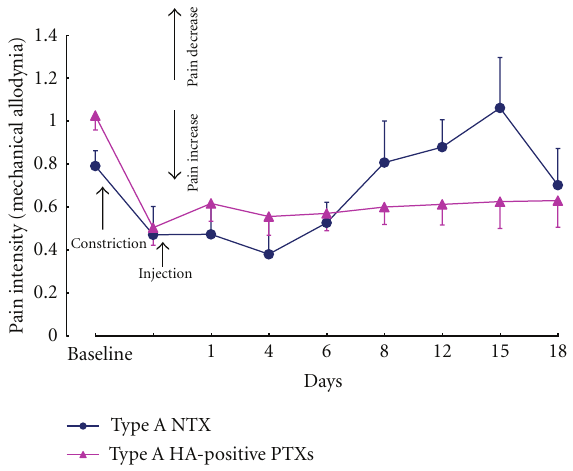
Figure 3: Mechanical allodynia after injection with type A NTX or PTXs in a rat hindpaw neuropathy model. Mechanical allodynia was tested with an electric von Frey filament and the hindpaw withdrawal thresholds measured. The data were divided by the contralateral na ¨ ıve hindpaw data. After sciatic nerve contraction, the ipsilateral hindpaw threshold was decreased. Ipsilateral injection with NTX or HA-positive PTXs produced the same toxicity (10 U/0.1mL) in mechanical allodynia. The e ff ects of NTX on decreasing pain levels were longer lasting than HA-positive PTXs. n = 4; data represent the mean ±